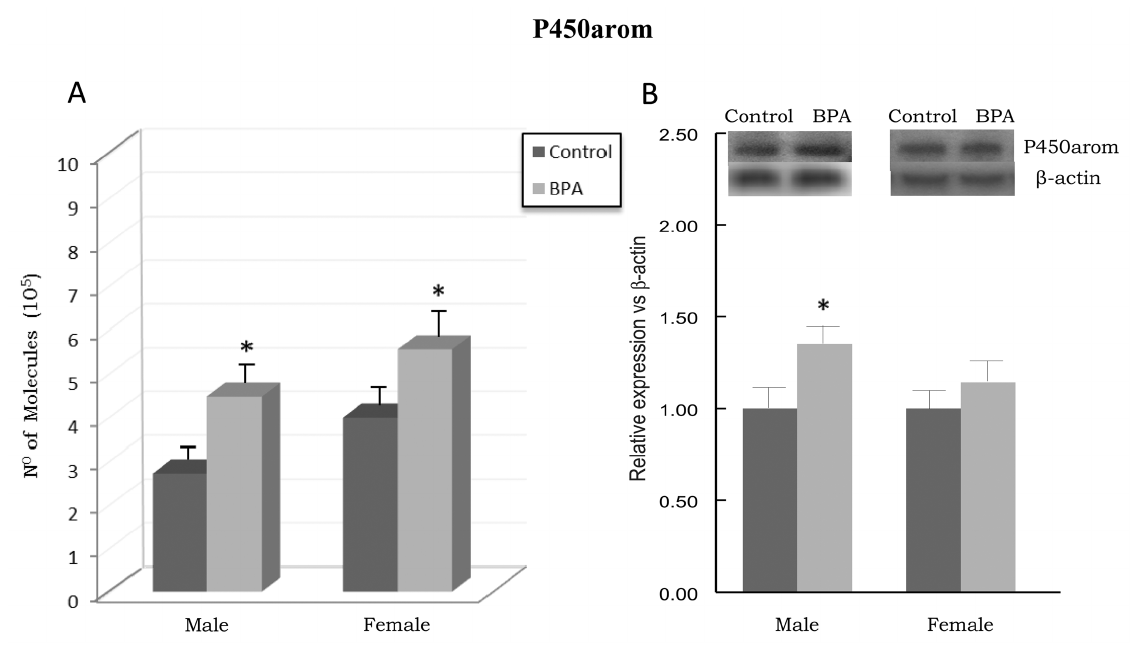
Figure 3. Effects of BPA on cytochrome P450 aromatase (P450arom) mRNA levels (panel A) and protein levels (panel B) in prefrontal cortex of BPA-treated male and female rats and their respective controls. * at least p , 0.05 vs. their controls.